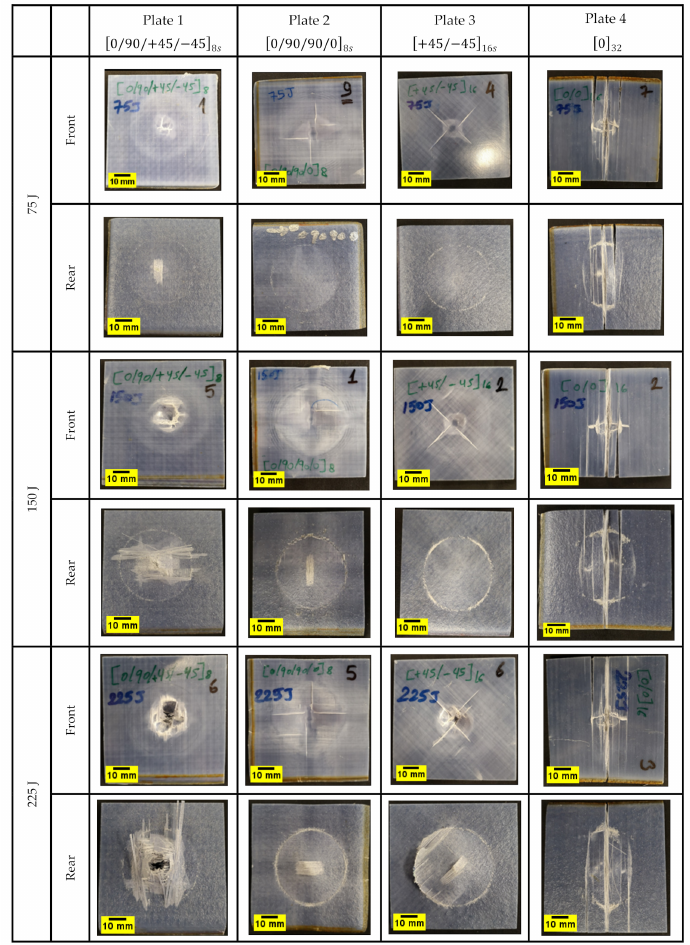
Figure 6. Front and rear images of the plates showing the resulting damage after